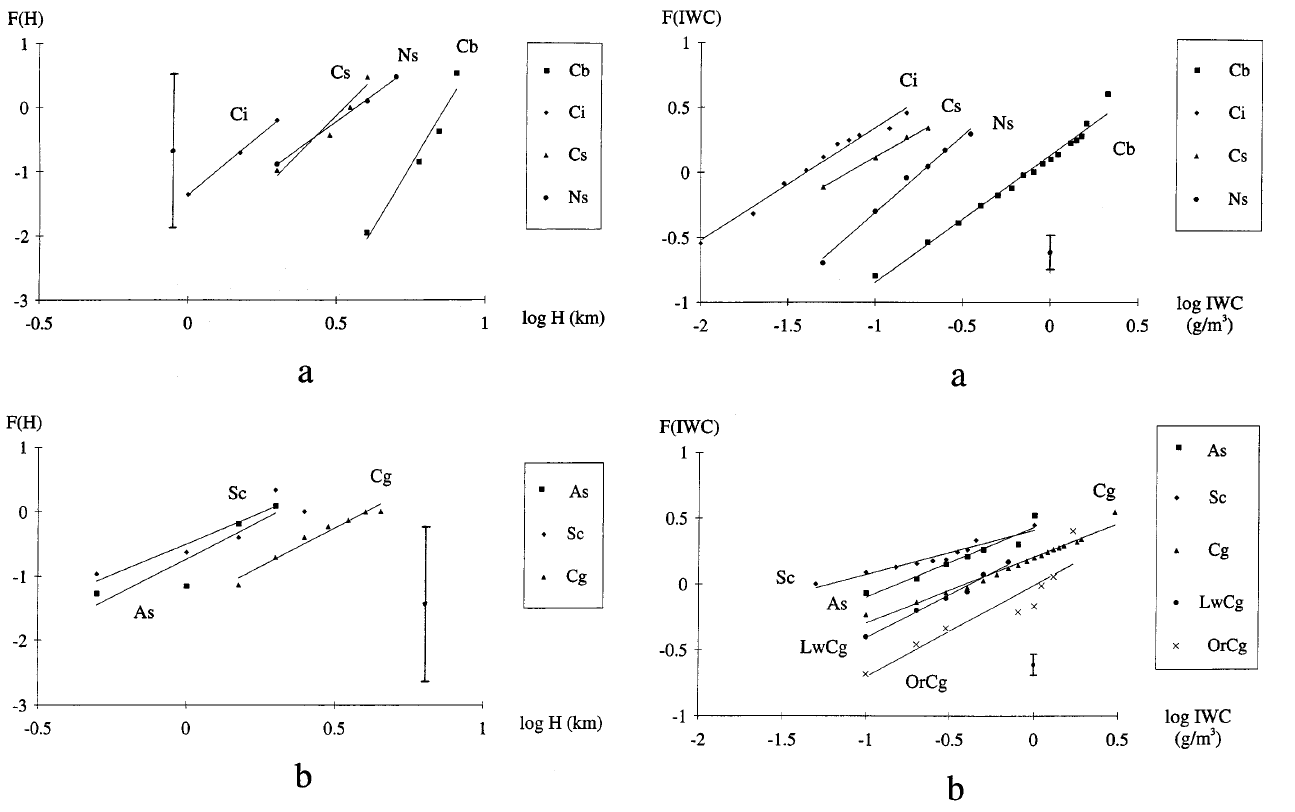
Fig. 6a, b. Cumulative frequency distributions of thickness ( H , in km) and Weibull fitting: a for types Cb, Ci, Cs, Ns; b for types As, Sc, Cg. Application of formula (16) with an accuracy of 20% on heights yields rather large errors of about (cid:6) 1 : 5 on distributions